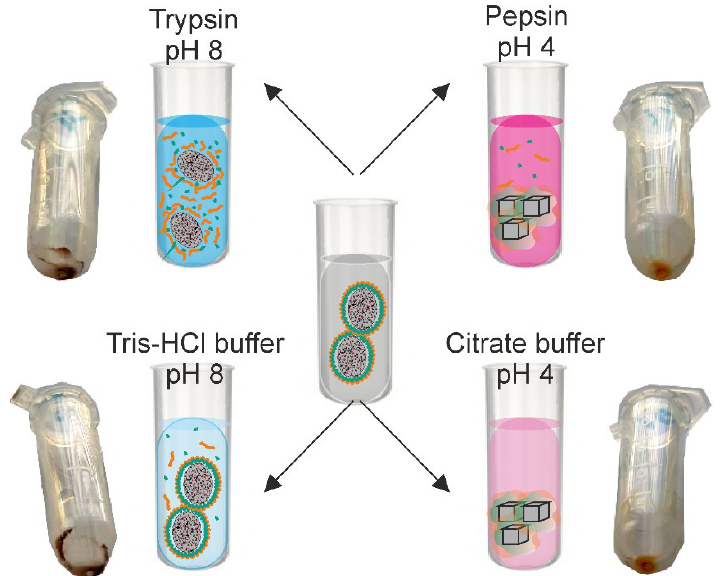
Figure 5. Interaction scheme of CaCO 3 /MNP 3 /(BSA-Cy7/TA) 2 carriers with enzymes and buffer solutions. The photos of the tubes demonstrate the relative amount of sediments obtained after centrifugation.